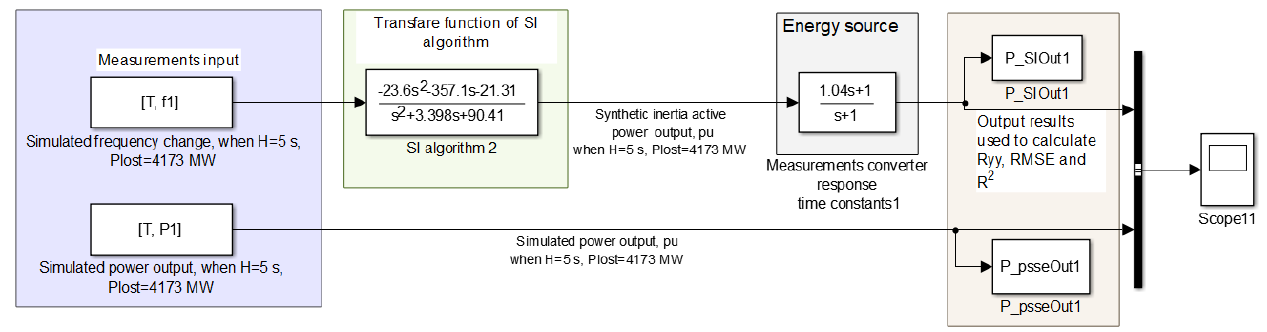
Figure 4. Research model developed in the Simulink environment (the Simulink model only presented one of five).